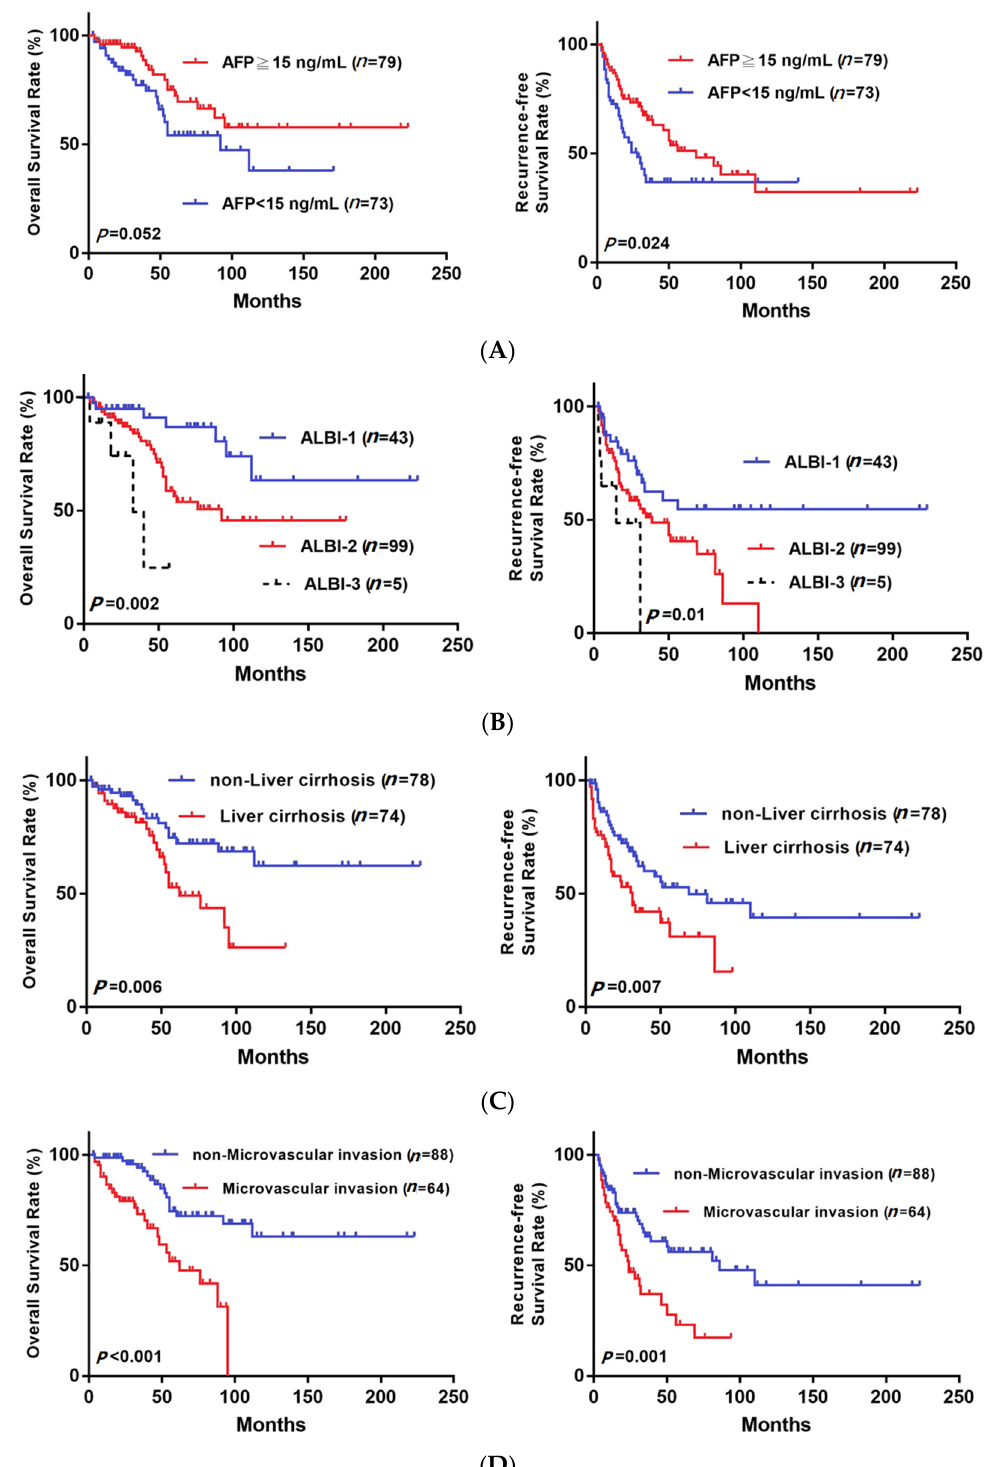
Figure 3. OS and RFS for all cases of BCLC 0/A stage HCC after curative resection stratified by